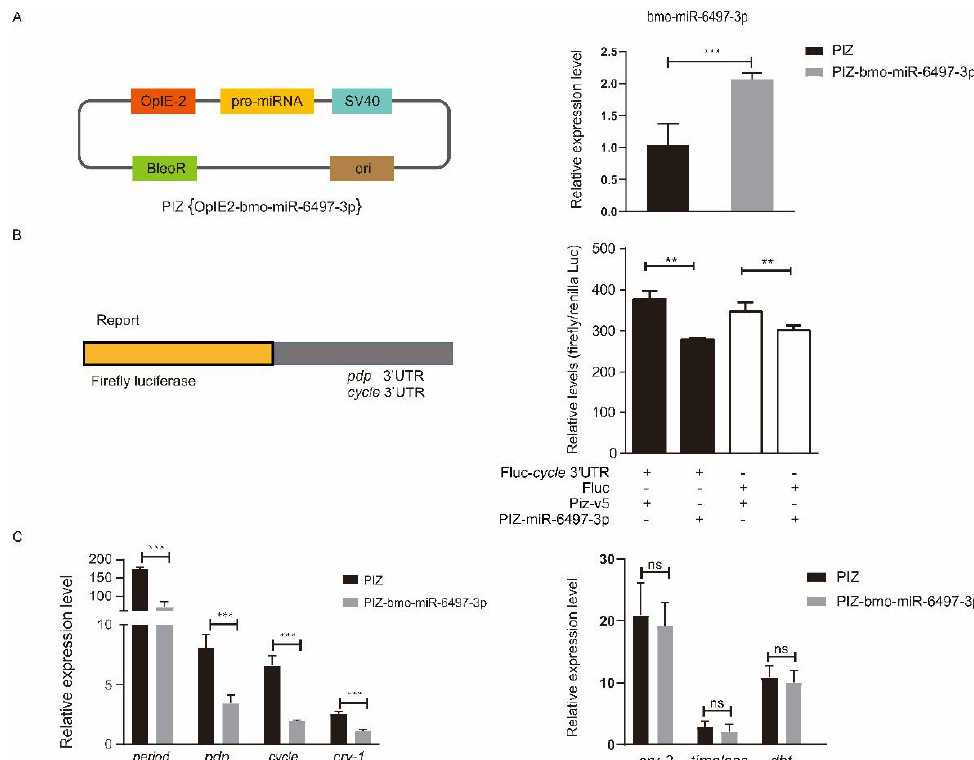
Figure 6. The core circadian clock gene cycle is a target of bmo-miR-6497-3p. ( A ) The bmo-miR-6497-3p expression level was significantly upregulated compared with the control group after transfecting the overexpression vector in silkworm embryo cells. ( B ) Luciferase reporter assays were performed after co-transfection with OpIE2-fluc-pdp/cycle 3′UTR or fluc together with an empty vector (PIZ-v5) or a bmo-miR-6497-3p expression vector (PIZ-v5-6497-3p). The Renilla reporter vector was co-transfected with vectors in all groups. For each condition, the luciferase value was normalized by Renilla luciferase and is shown as the mean ± standard deviation (SD). ( C ) bmo-miR-6497-3p inhibits the expression levels of some circadian clock genes in vitro. Silkworm embryo cells transfected with PIZ or PIZ-miR-6497-3p were analyzed for the changes in expression levels of circadian rhythm-related genes. Each experiment was performed three times independently, and all expression profile results obtained with three biological replicates and three technical replicates are shown with means ± SD. “*” represents that 0.01 ≤ p value ≤ 0.05, “**” represents that 0.001 ≤ p value ≤ 0.01, and “***” represents that p value ≤ 0.001.